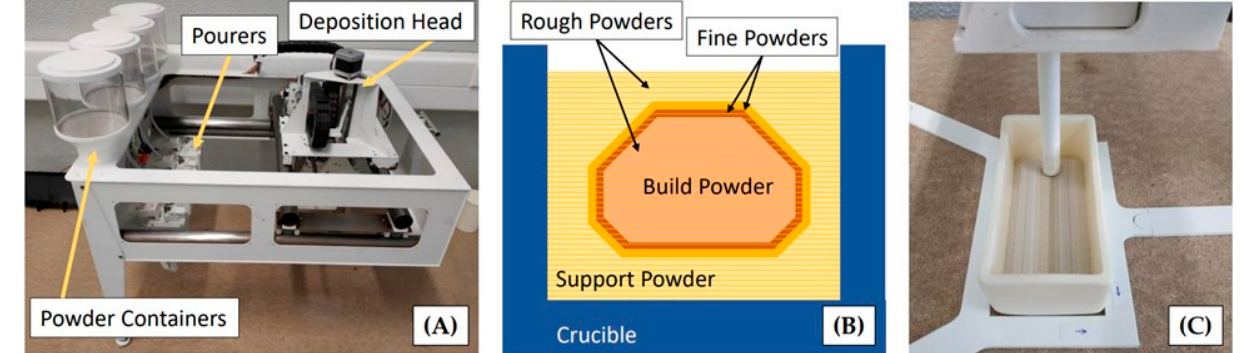
Figure 1. The iro3d selective powder deposition (SPD) process. ( A ) Iro3d model C machine with main components identified. ( B ) Section view scheme of the crucible with support and build powders inside, after the deposition stage and before sintering. ( C ) Example of a pourer depositing glass powders inside an alumina crucible.